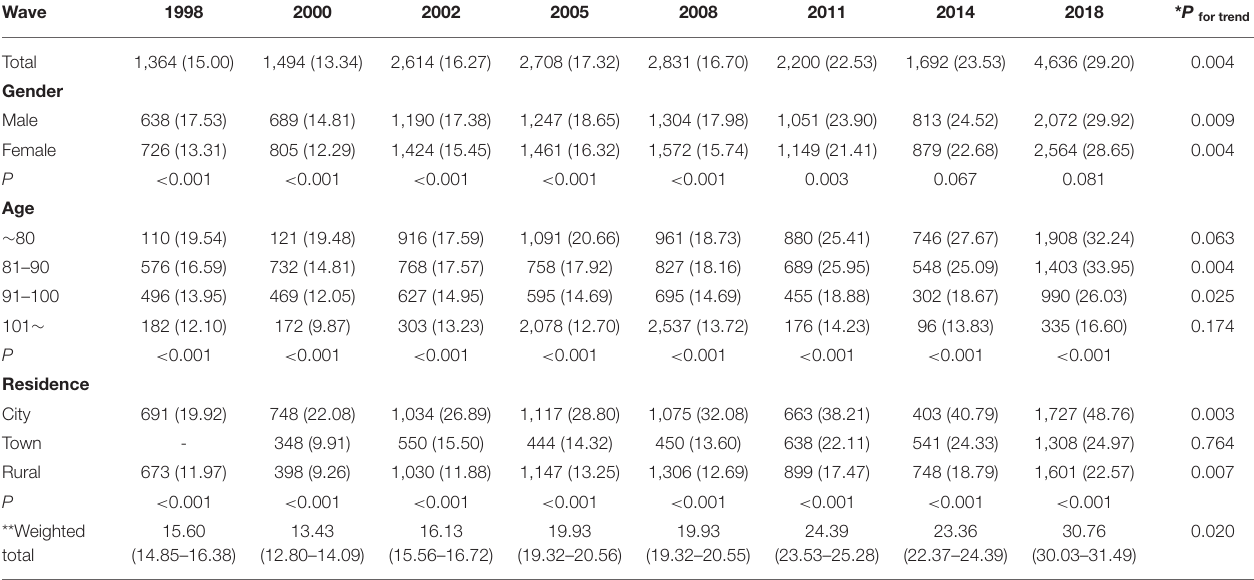
TABLE 1 | Prevalence of multimorbidity by the subpopulations across the survey of eight waves.